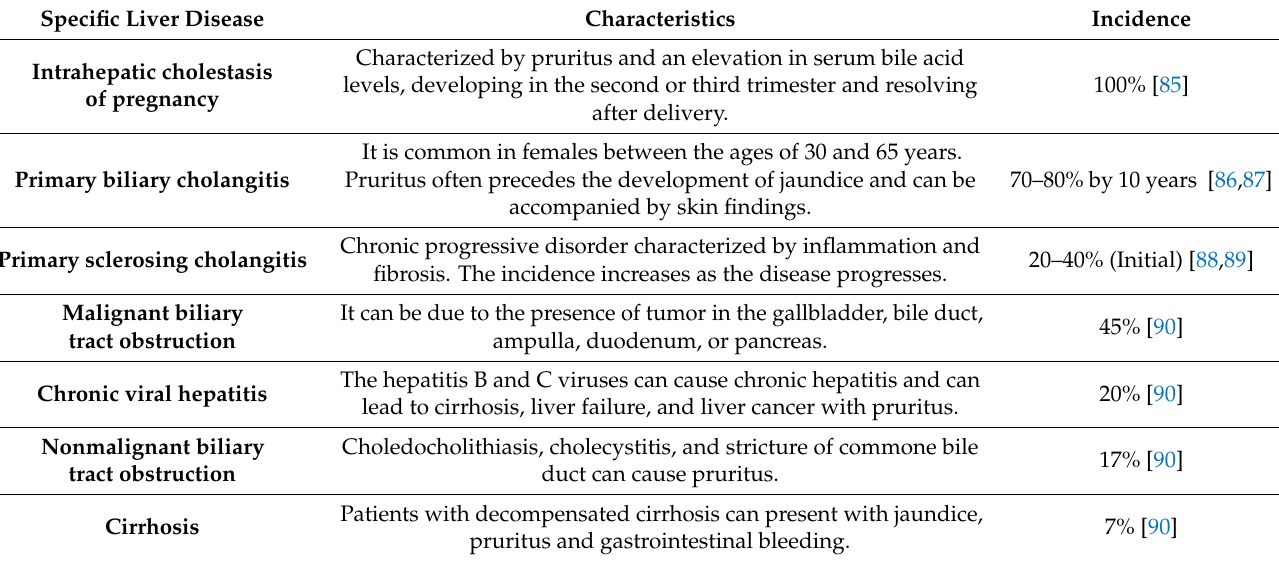
Table 3. Frequency of cholestatic pruritus according to the type of liver